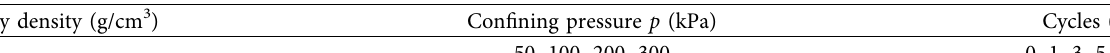
Table 4: CD experimental scheme.